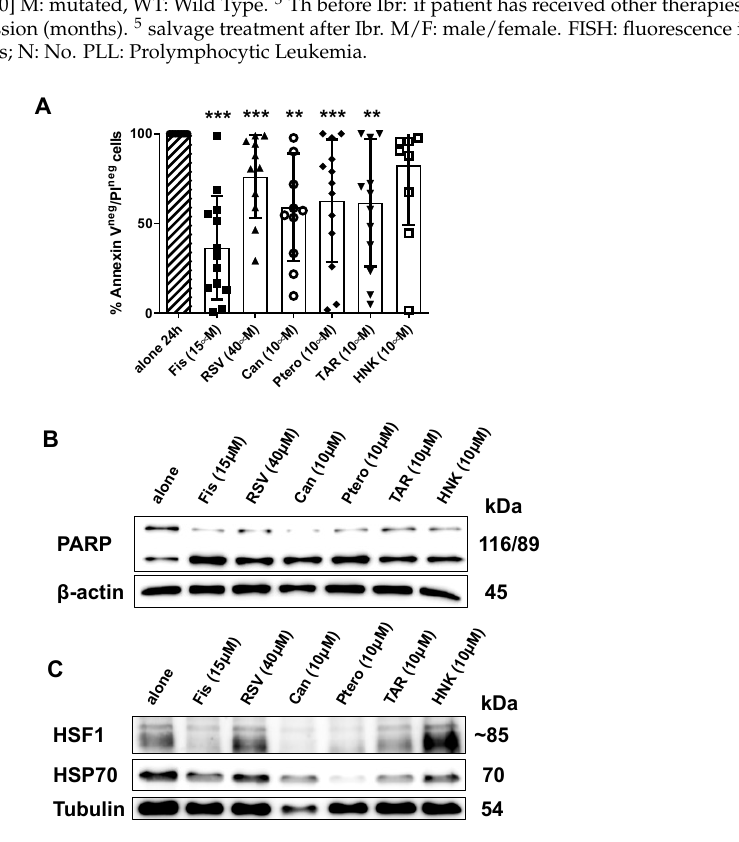
Figure 5. Resveratrol and related compounds induce apoptosis in leukemic B cells from patients who failed Ibrutinib treatment. ( A ). Leukemic B cells from CLL patients failing Ibrutinib treatment were cultured alone or in the presence of 15 µM Fis, 40 µM RSV, 10 µM Can, 10 µM Ptero, 10 µM TAR and 10 µM Hnk and cell apoptosis was analyzed by annexin V/PI flow cytometric test. Histo- grams report the percentage of Annexin V neg /PI neg cells after 24 h treatment and the treated condi- tions were normalized on the untreated one. Data are reported as mean ± SD (** p < 0.01 and *** p < 0.001, paired Student’s t test; n = 13). ( B ). Lysates obtained from CLL B cells from patients failing Ibrutinib treatment cultured alone or with 10 µM Fis, 40 µM RSV, 10 µM Can, 10 µM Ptero, 10 µM TAR and 10 µM Hnk were analyzed by immunostaining with anti-PARP for apoptosis detection and anti- β -actin as loading control. Western blotting is representative of all the cases analyzed ( n = 13). ( C ). Lysates obtained from CLL B cells form patients failing Ibrutinib treatment cultured alone or with 10 µM Fis, 40 µM RSV, 10 µM Can, 10 µM Ptero, 10 µM TAR and 10 µM Hnk were analyzed